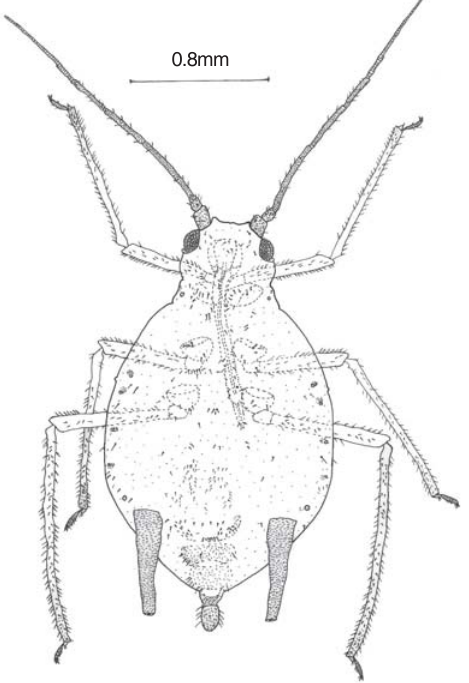
Figure 4. Aphis nerii Boyer de Fonscolombe (Apterous)